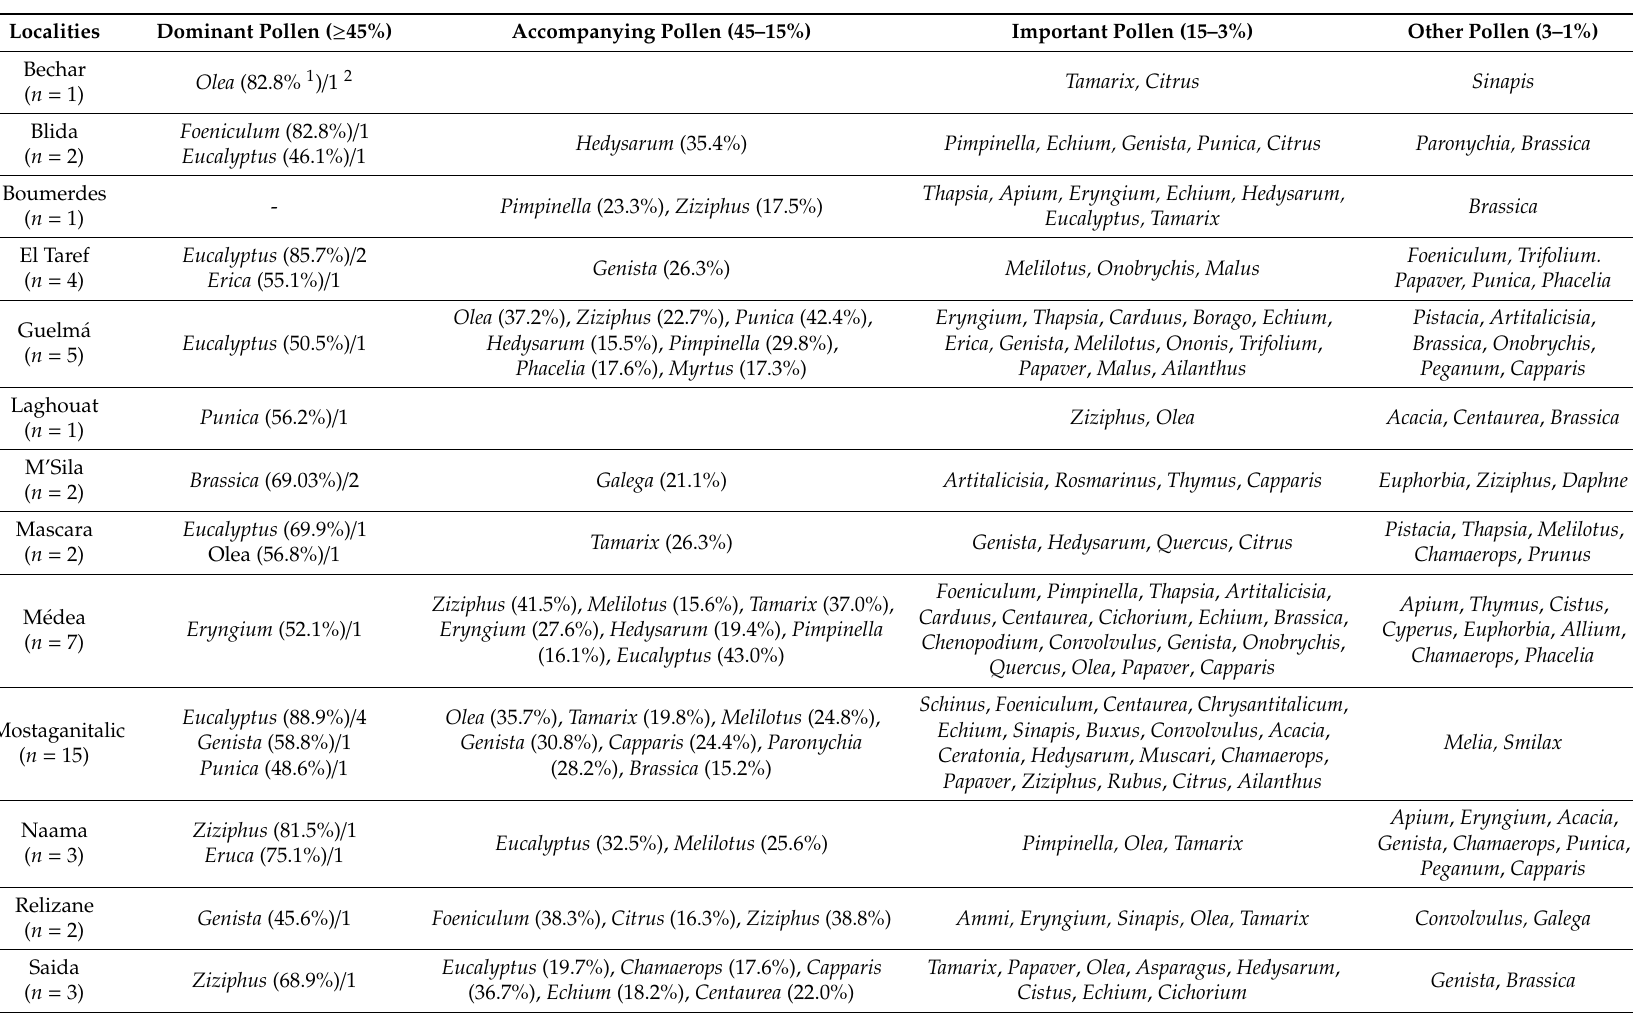
Table 2. Main palynological characteristics regarding geographical